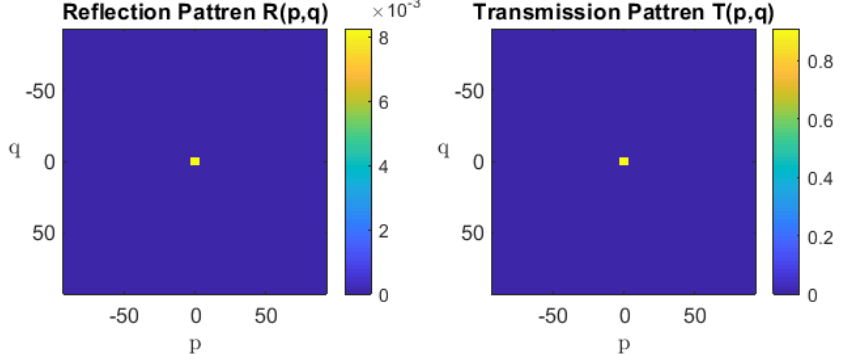
Fig. 4. Spatial harmonics power composition studies. Transmission and reflection coefficient dependence on spatial harmonics. The main energy of microwave radiation is contained only in the main spatial